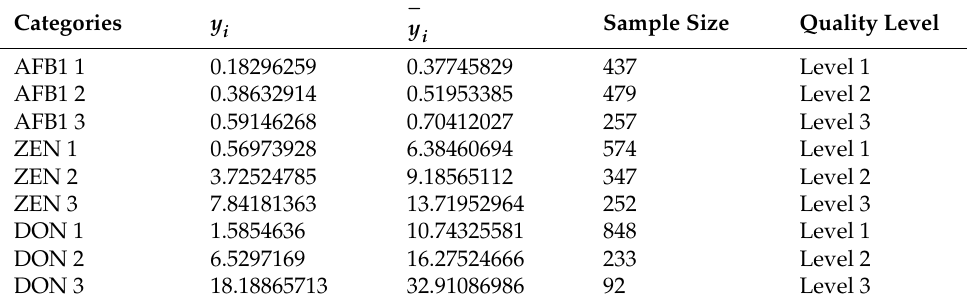
Table 5. Clustering centers and ranking of three clusters of wheat.